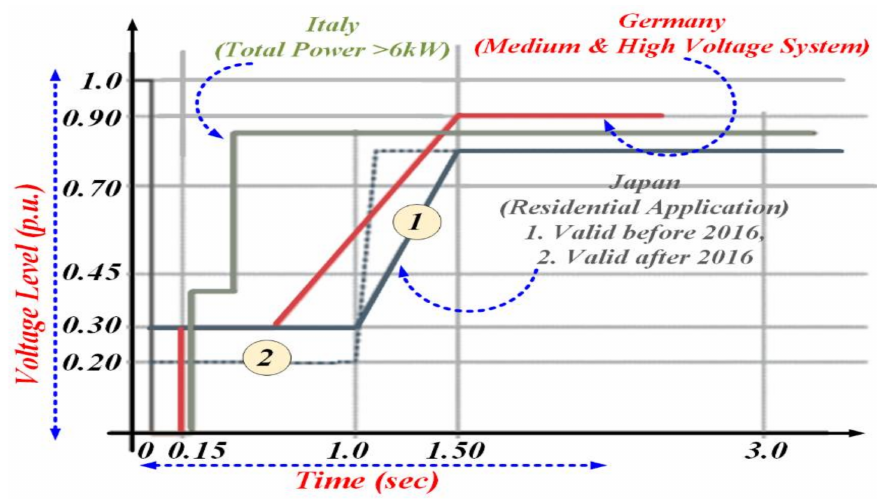
Figure 2. LVRT requirements defined by various country’s grid codes covering wide-scale applications [10,11].